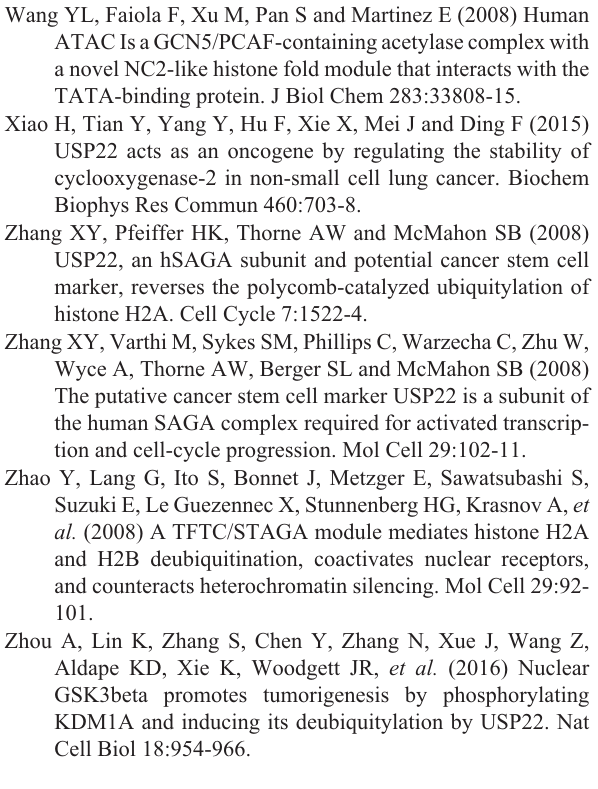
Table S1 – Primers for validation of ChIP-target genes. Table S2 – Primers for validation of down-regulated genes. Table S3 – Target genes in USP22 ChIP-seq. Table S4 – Target genes in GCN5 ChIP-seq. Table S5 – Target genes in USP22